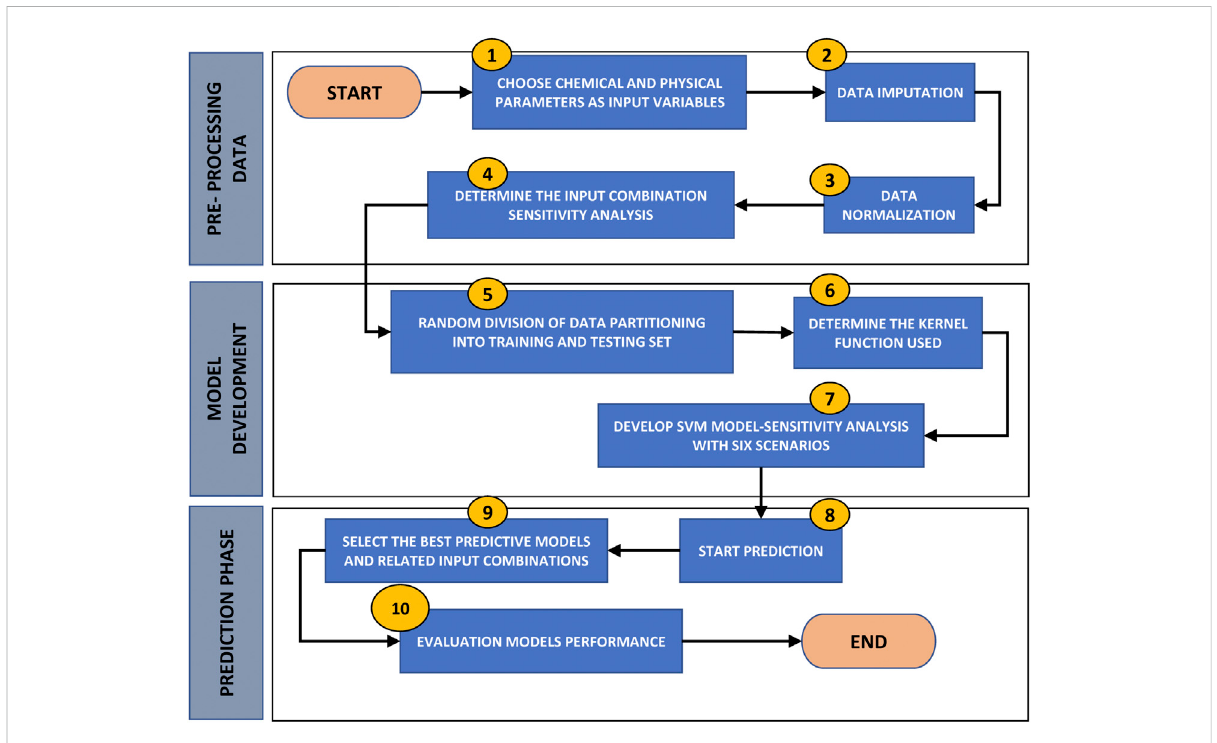
FIGURE 2 Overview of work fl ow to build the predictive